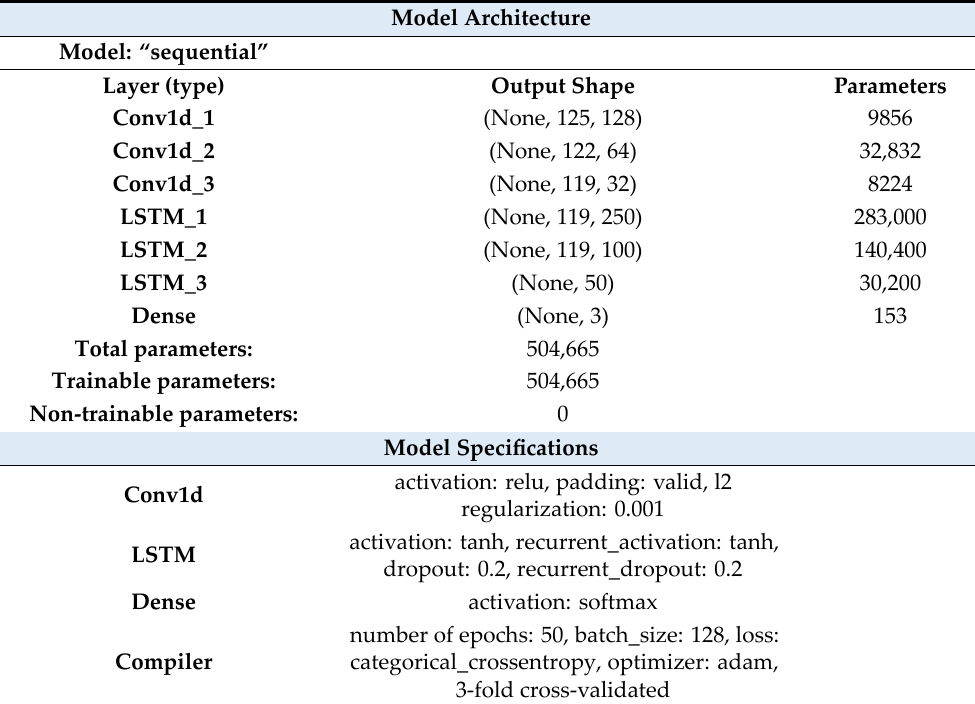
Table 5. Model summary for Phase 2. Note that 3‑fold cross‑validation was used, and SoftMax was used rather than the Sigmoid activation function in Phase 1, with a far greater number of parameters for each layer than before (these terms are explained in the online Supplementary Materials).